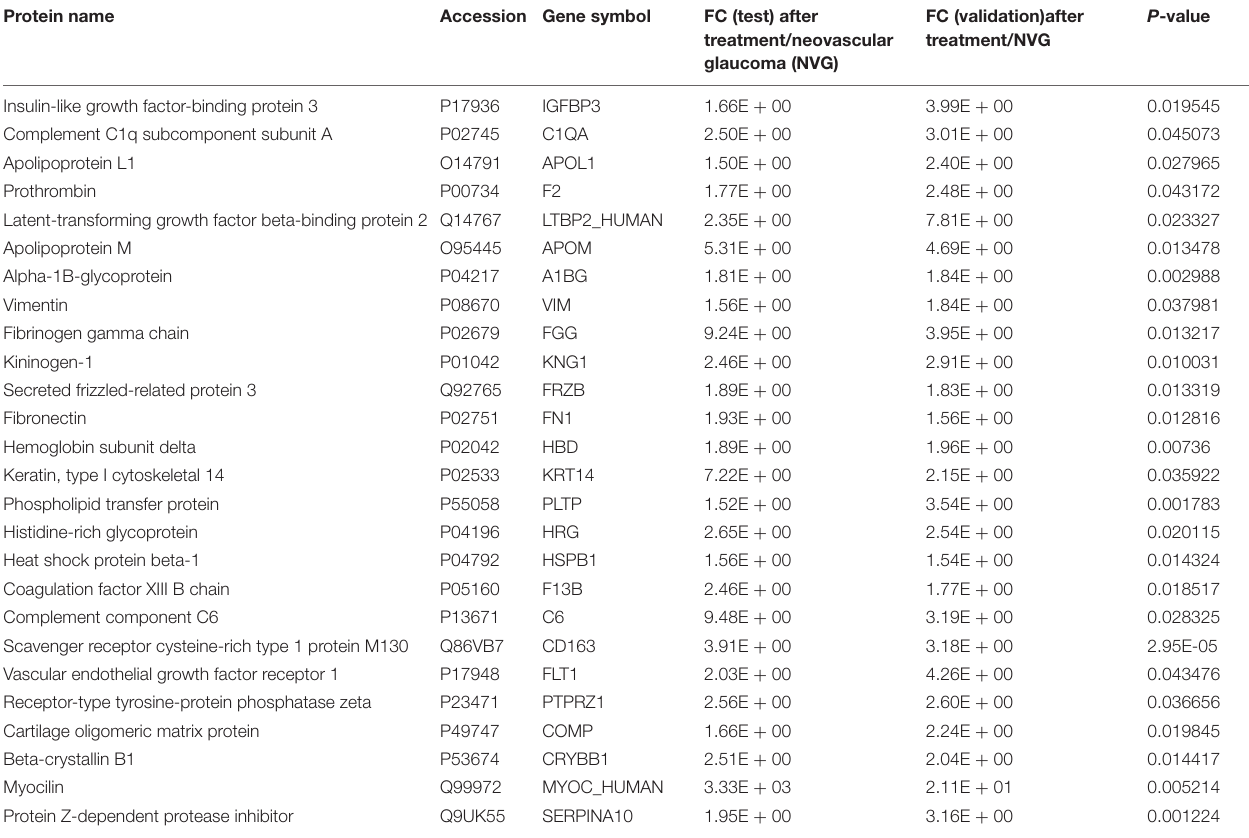
TABLE 3 | The differently expressed proteins (DEPs) (26) that were validated using PRM technology (all up